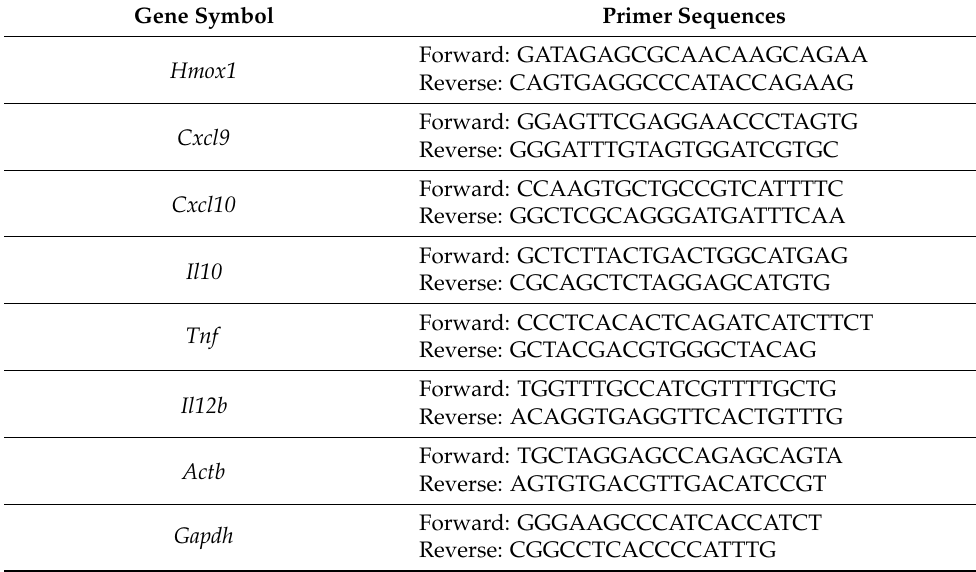
Table 1. The sequences of primers used for PCR